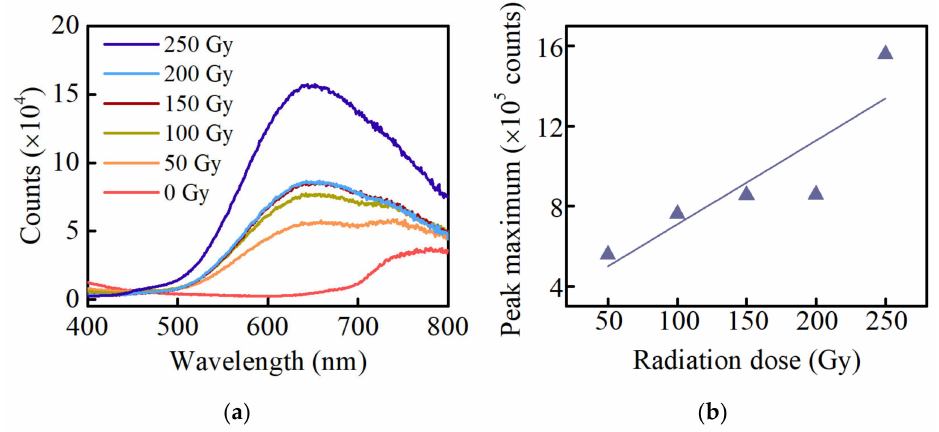
Figure 2. ( a ) The fluorescence spectra of the Ag-doped phosphate glasses at different radiation doses; ( b ) the linear relationship between the RPL peak maximum intensity of the Ag defect centers at 650 nm and the radiation dose in the Ag-doped phosphate glasses. (310 nm excitation).